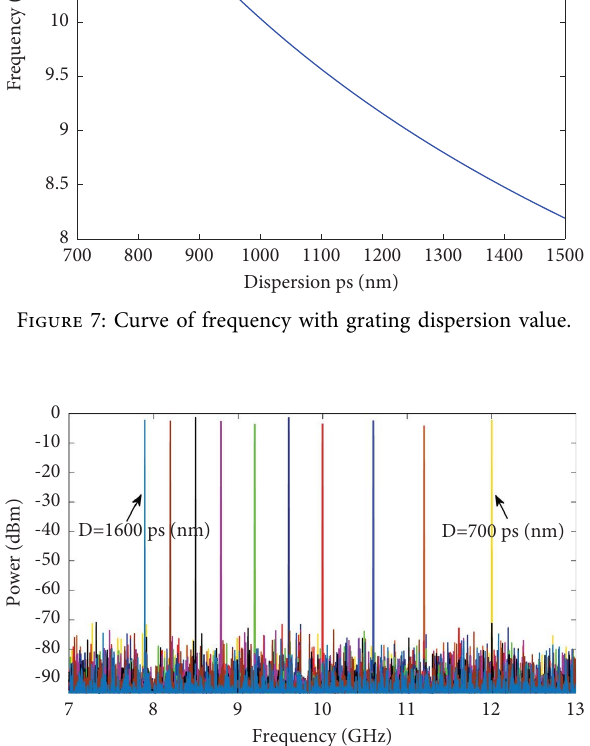
Figure 8: Fiber grating dispersion characteristics of the source.